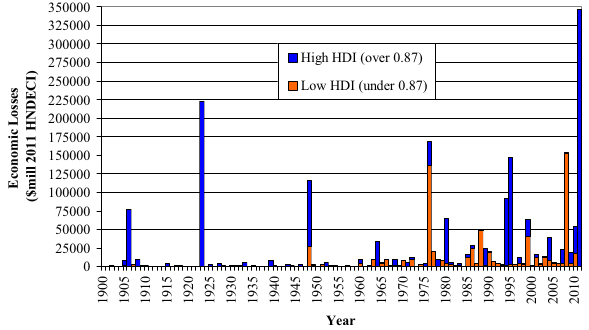
Fig. 15. Economic Losses (2011 Hybrid Natural Disaster Economic Conversion Index adjusted) for 7000+ earthquakes from the year 1900–2011 worldwide (Daniell et al.,